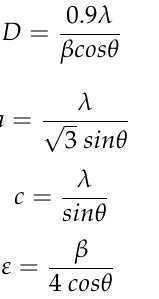
Figure 2. (a , b ) SEM images; ( c ) electronic image corresponding to EDX analysis; ( d ) EDX spectrum; ( e , f ) TEM results of the ball-mill-fabricated